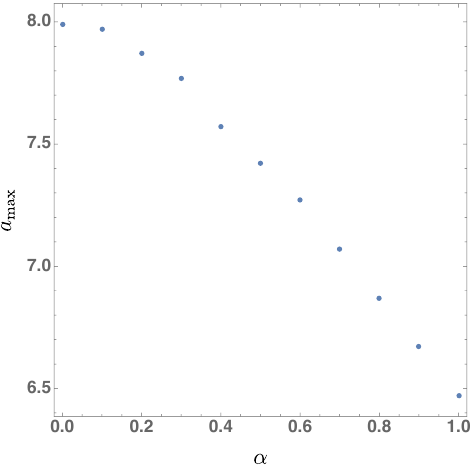
Figure 1 . Logarithmic plot of the maximum of the Kretschmann scalar, over the whole spacetime, as a function of the boundary amplitude a for (cid:11) = 1. Di(cid:11)erent values of (cid:11) show a similar qualitative behaviour. The red dashed line denotes the curvature of pure AdS.